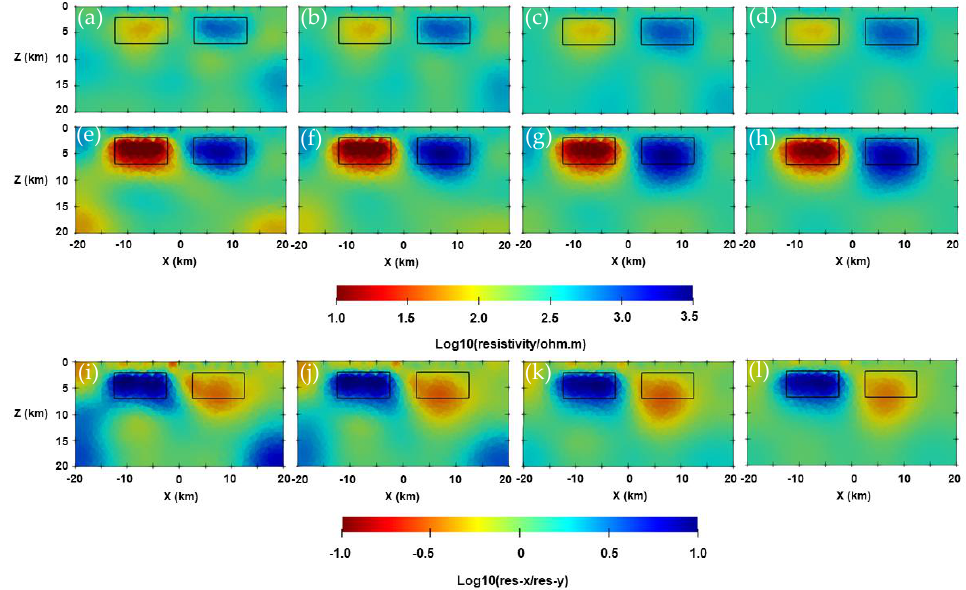
Figure A3. Anisotropic inversion results at y = 0 km for different 𝑞 𝑖 , and 𝑐 = 1 . Panels ( a ) – ( d ) show the inverted resistivity in the principal X direction for 𝑞 𝑖 = 0.05,0.1,0.4, 0.8 . Panels ( e ) – ( h ) show the inverted resistivity in principal Y direction for 𝑞 𝑖 = 0.05,0.1, 0.4,0.8 . Panels ( i ) – ( l ) show the inverted anisotropic coefficient for 𝑞 𝑖 = 0.05,0.1,0.4,0.8 .